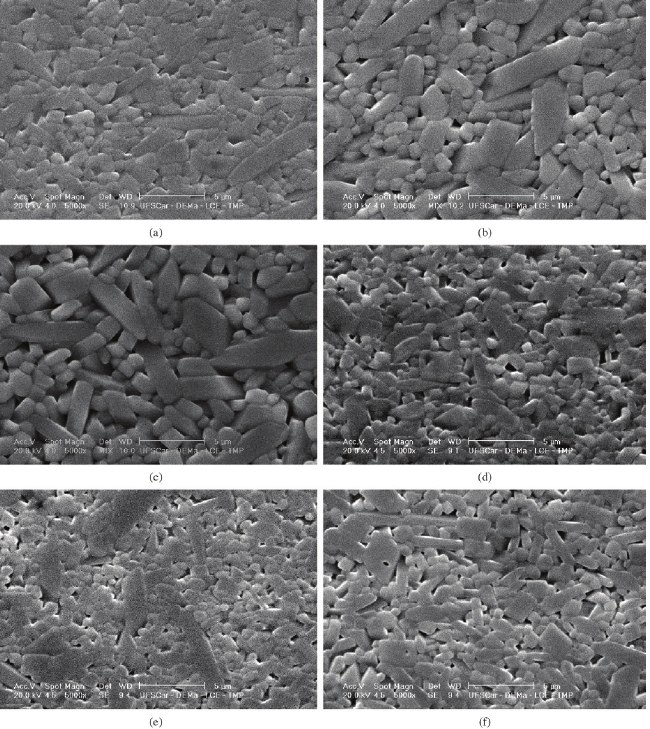
Figure 10. SEM micrographs of samples fast sintered at a heating rate of 40 o C/min: (a) 0.5M, (b) 1M, (c) 2M, (d) 0.5L, (e) 1L, and (f) 2L.